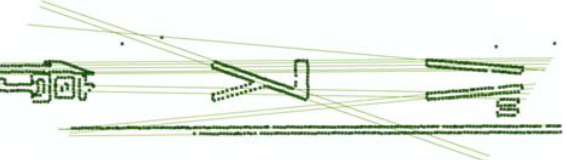
Figure 13. Extracting lines with large